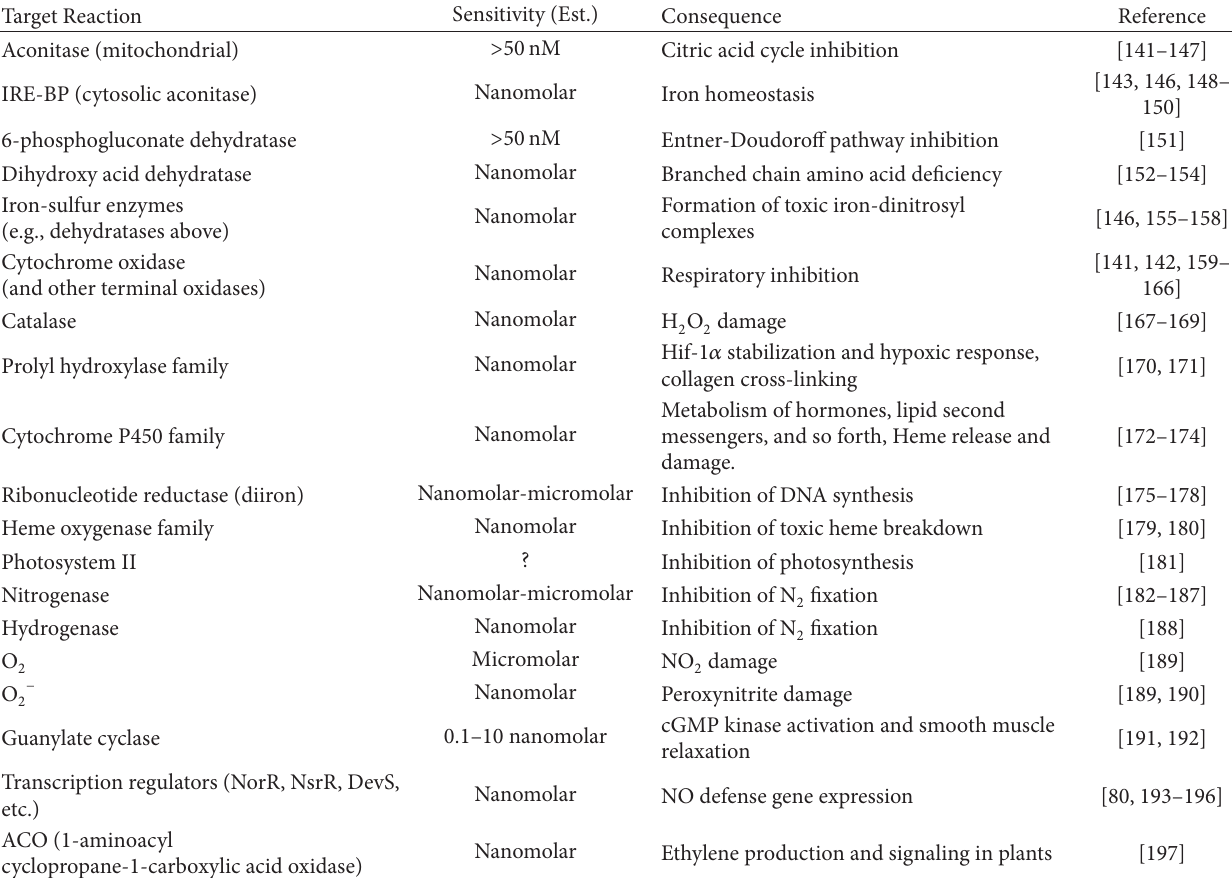
T 1: Some important biological targets and actions of